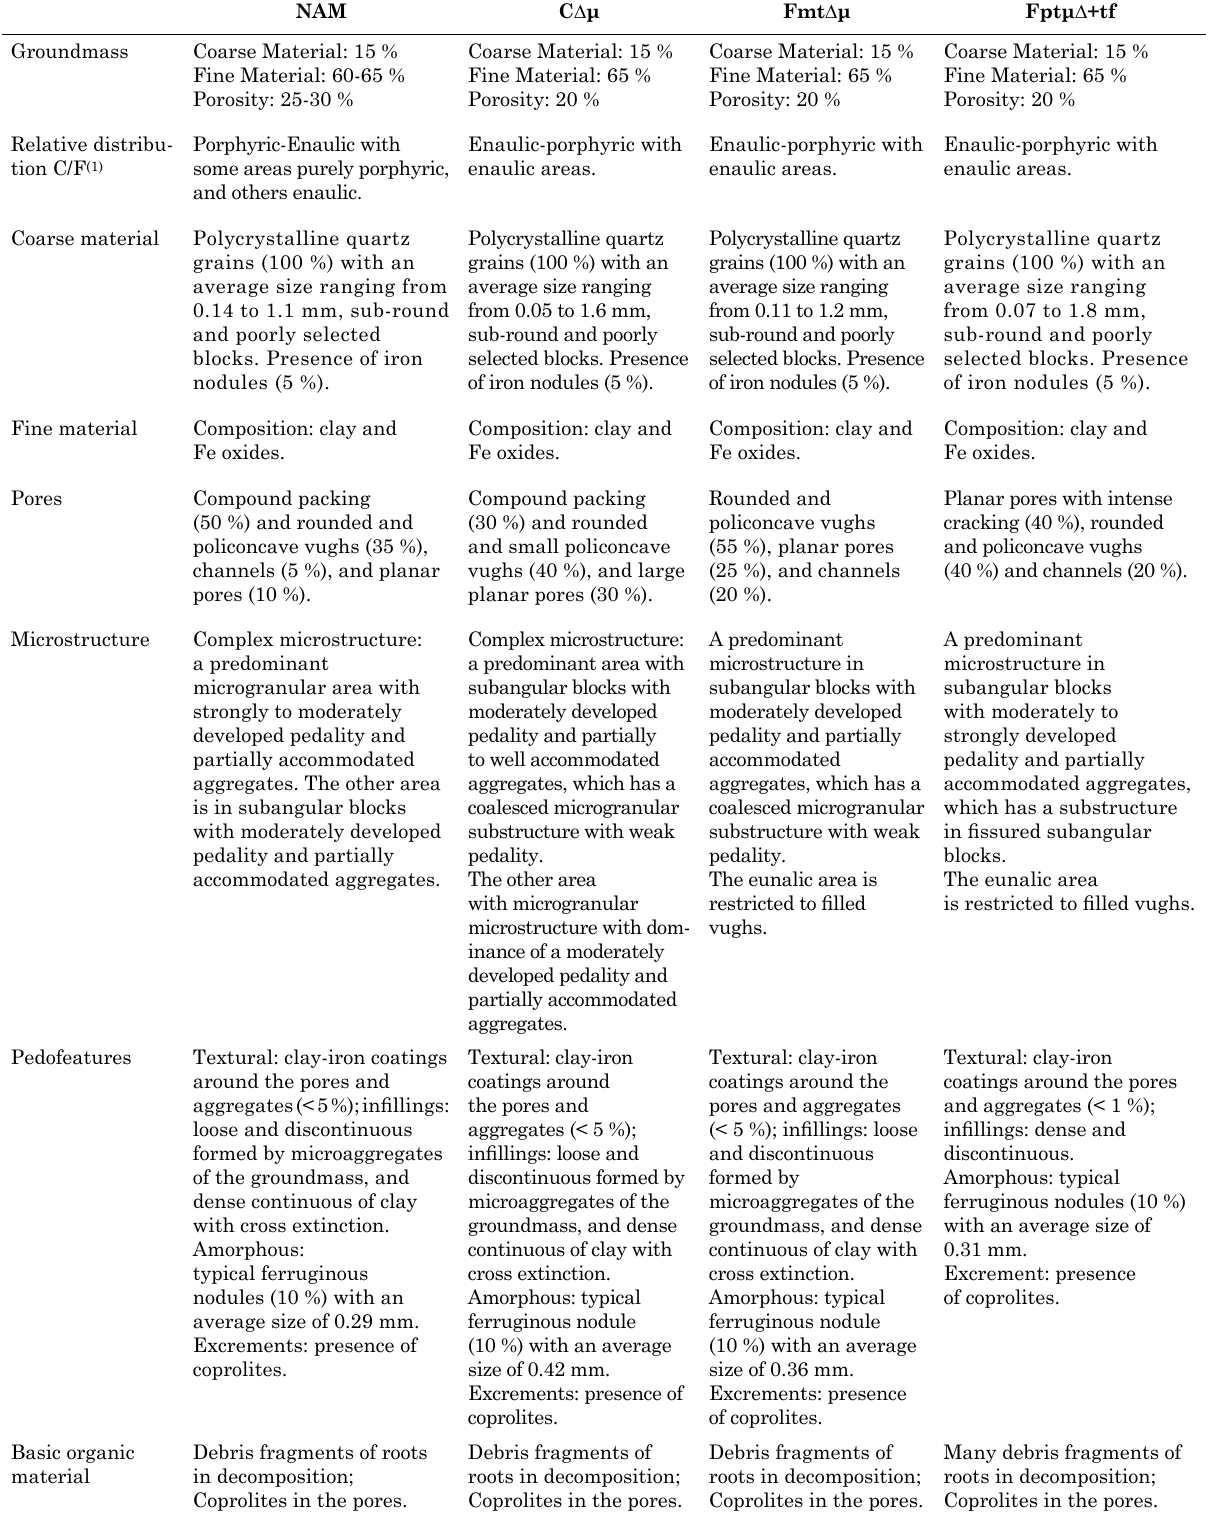
Table 1. Micromorphological characteristics of the morphologically homogeneous units (MHUs) of the soil profile of the Memory Plot